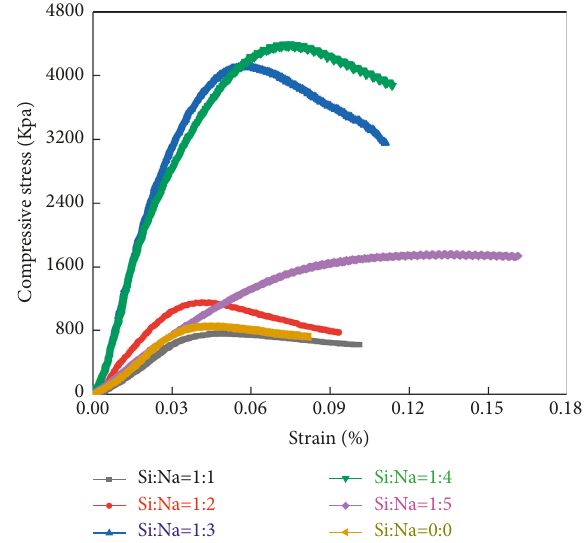
Figure 7: Compressive strength